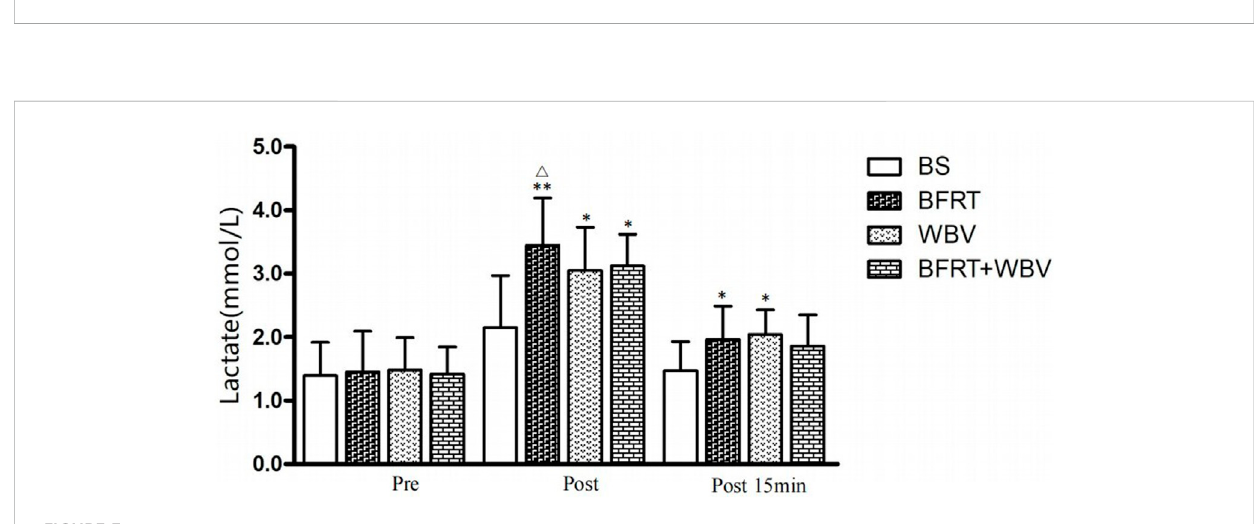
FIGURE 3 Changes in blood lactate concentration before and after